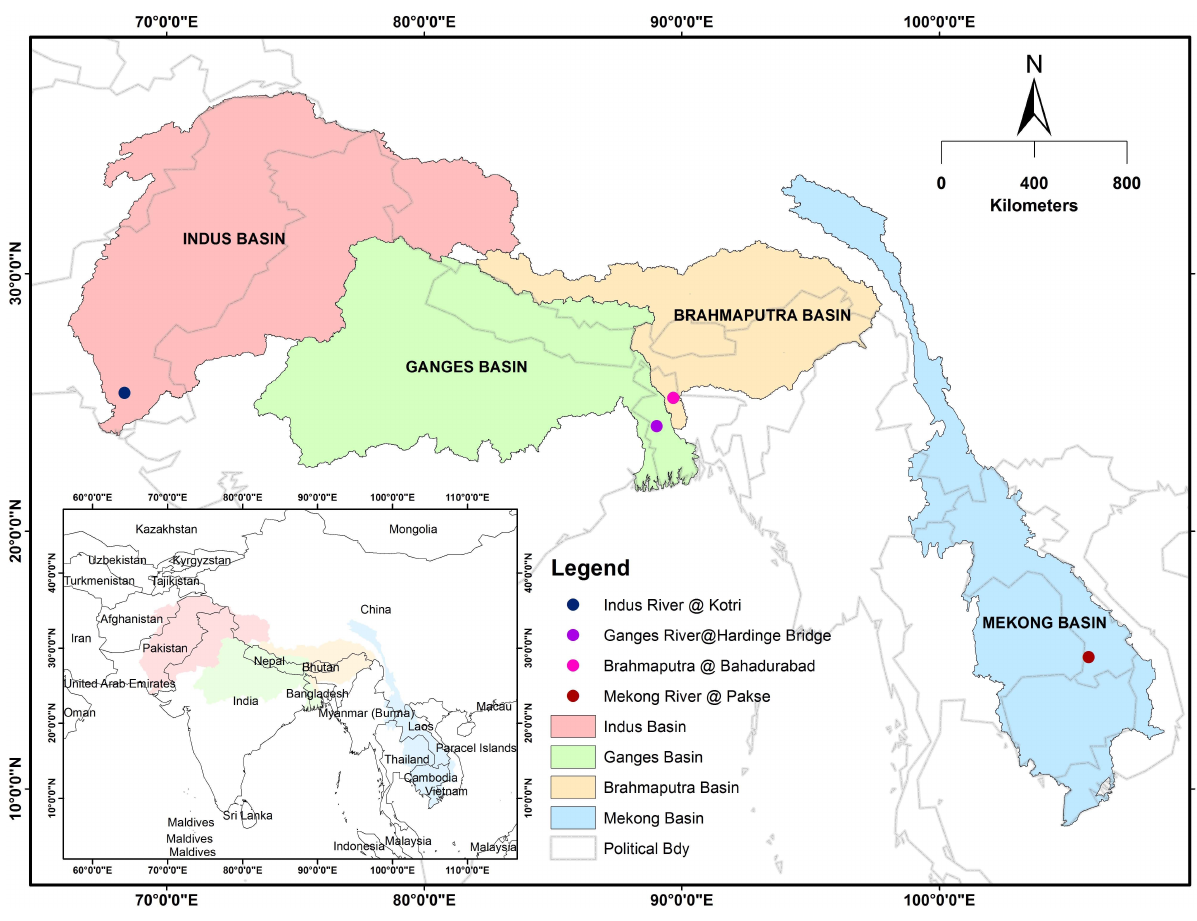
Fig. 1. Four study river basins: Indus, Ganges, Brahmaputra and Mekong (west to east).